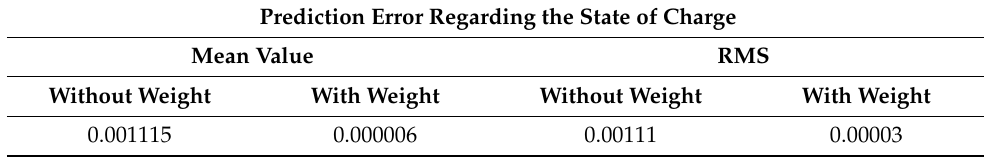
Table 6. Mean and RMS values of the prediction error (state of charge).